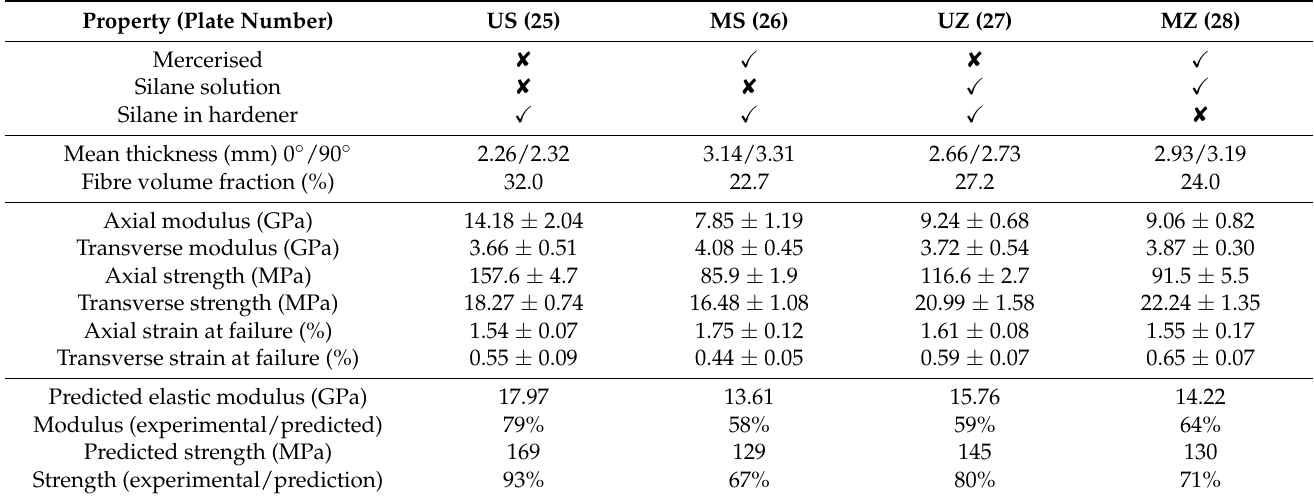
Table 4. Longitudinal and transverse tensile properties for flax fibre composites with different fibre treatments and the addition (or not) of silane in the